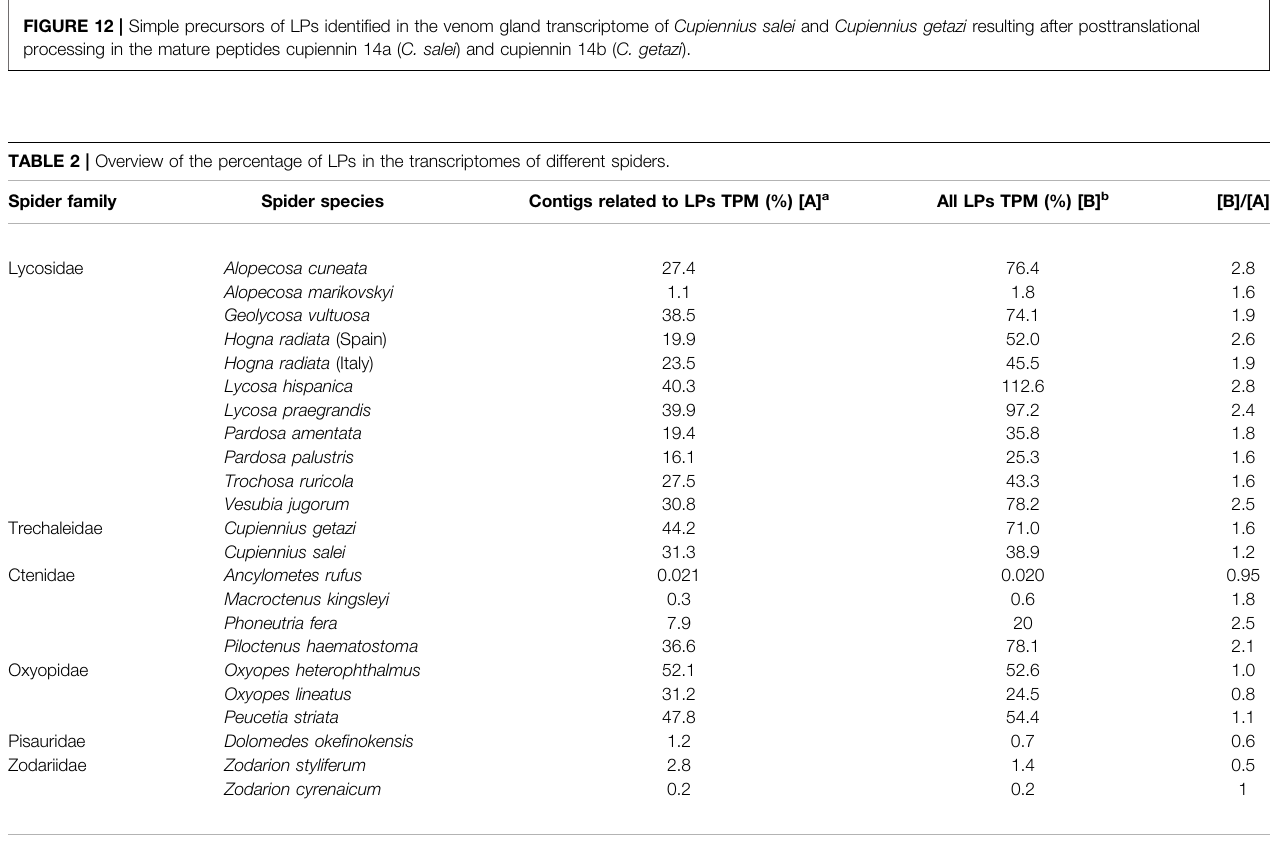
Frontiers in Molecular Biosciences |